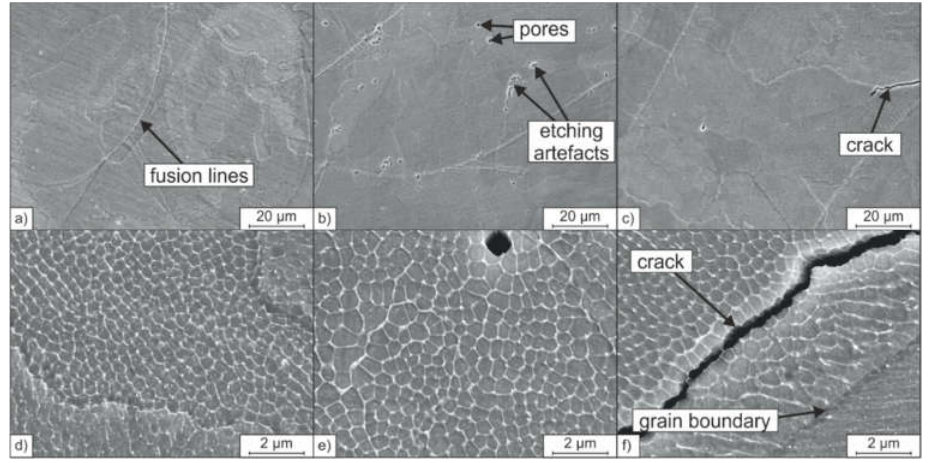
Figure 6. SEM micrographs of the microstructures of the samples: ( a ) A-PBF, ( b ) B-PBF, ( c ) C-PBF at low magnification; ( d ) A-PBF, ( e ) B-PBF, ( f ) C-PBF at high magnification. Solid-state cracking in austenitic steels is reported in welding technology [35].